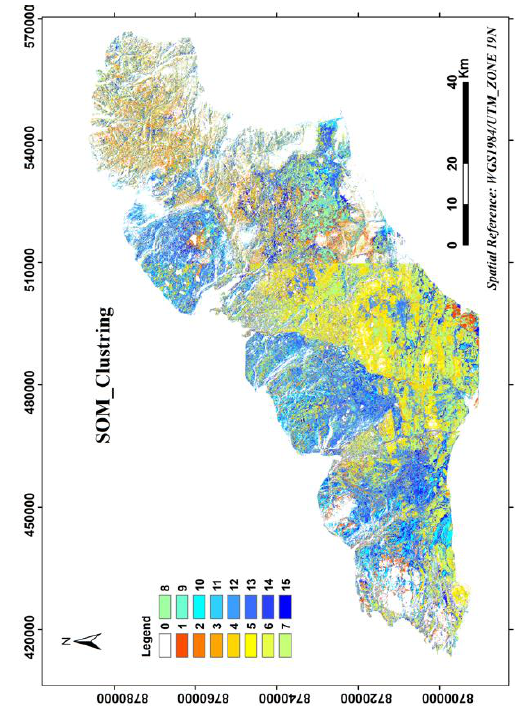
Figure 7. SOM clustering of the Inglefield Land Sentinel-2 data. Locations covered by snow have been masked (white Figure 5. Lineaments based from applying directional filters to remote sensing data.